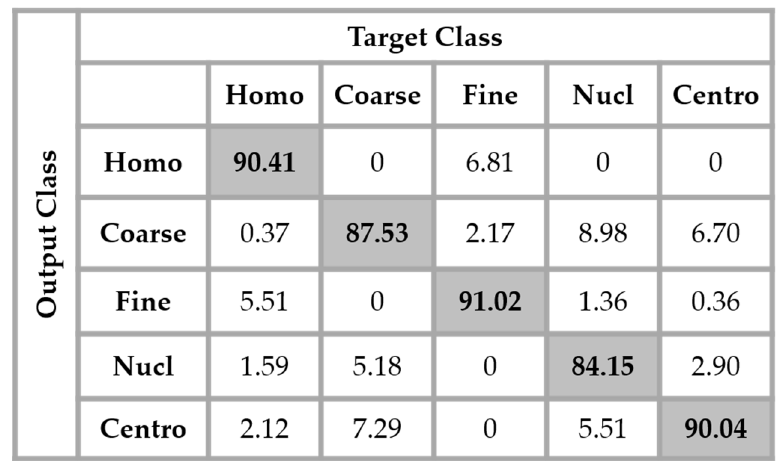
Figure 13. Confusion matrix of the results over the testing set by using the original cellular images as the inputs of one single network with data augmentation. The total accuracy of the network is 88.63%.